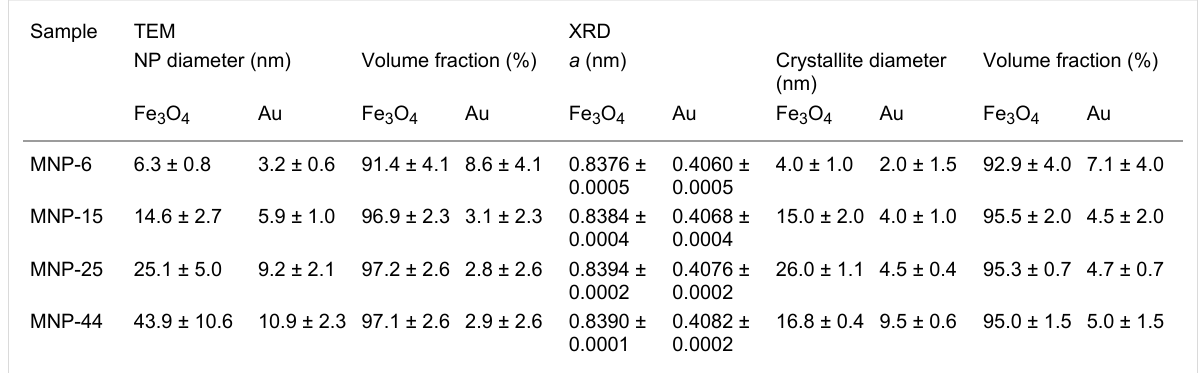
Table 1: Results of the structural and morphological characterization by TEM and XRD. The NP size distribution, volume fraction of Fe 3 O 4 and Au, lattice parameter ( a ), and crystallite size are listed. Sample